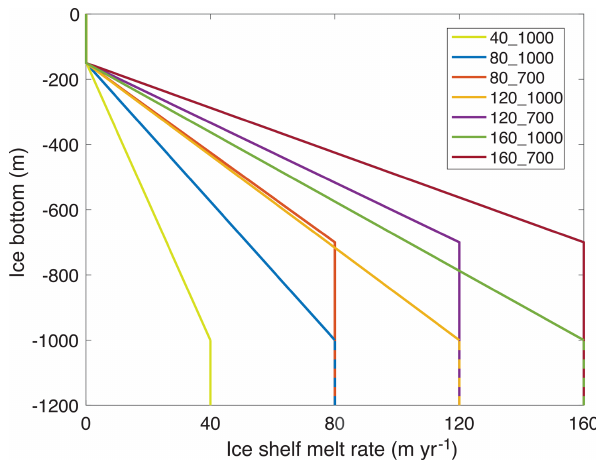
Figure 2. Ice shelf melt rate parameterization for the seven ocean thermal forcing